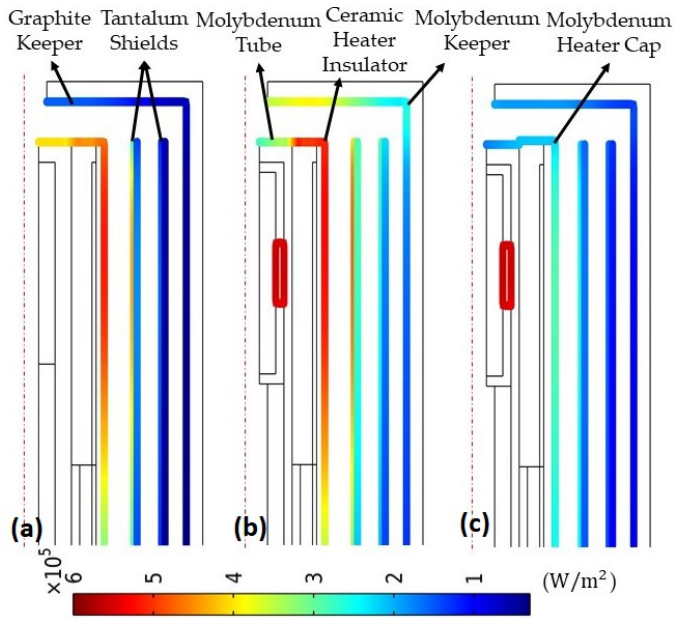
Figure 7. Radiosity of cathode inner surfaces: ( a ) Two concentric tantalum shields; ( b ) Molybdenum cathode tube and keeper; ( c ) Molybdenum cap around